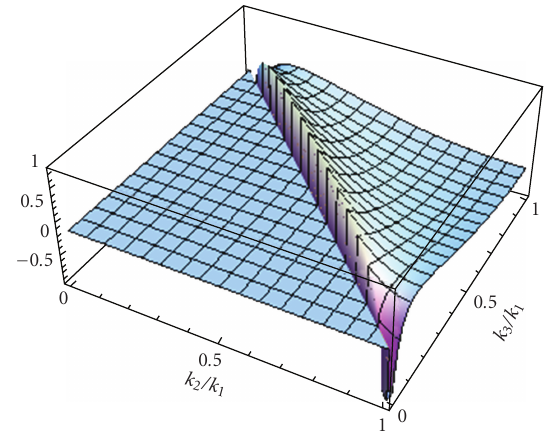
Figure 21: Another factorizable orthogonal ansatz